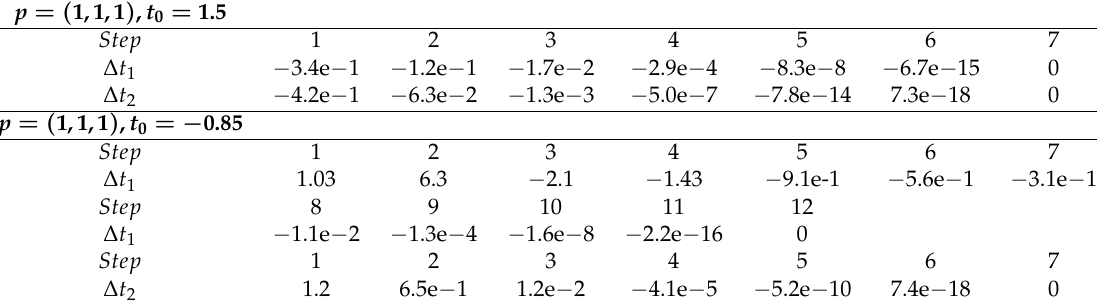
Table 1. Stepsizes ∆ t 1 , ∆ t 2 in Example 1 for the Newton’s method and our second-order algorithm. p = ( 1,1,1 ) , t 0 =